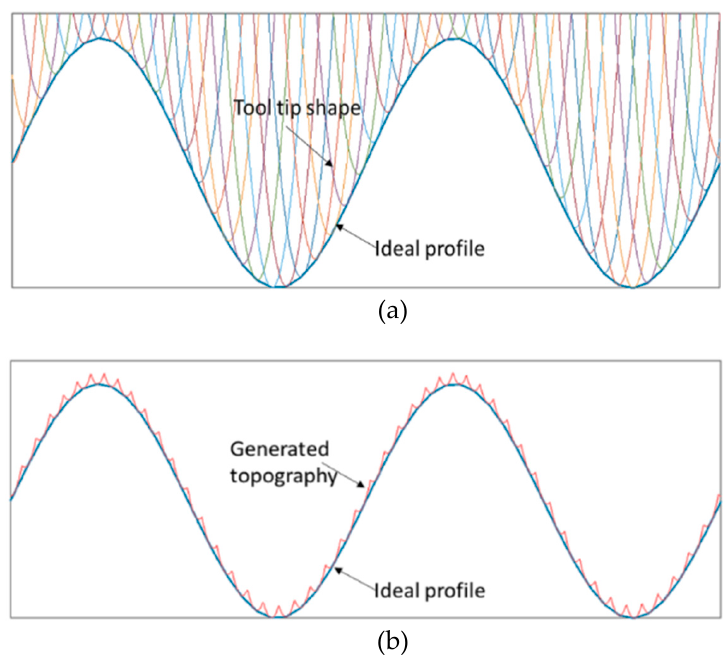
Figure 13. Simulation of topography generation along the radial profile: ( a ) Successive tool tip profiles along the feeding direction; ( b ) Resulting topography